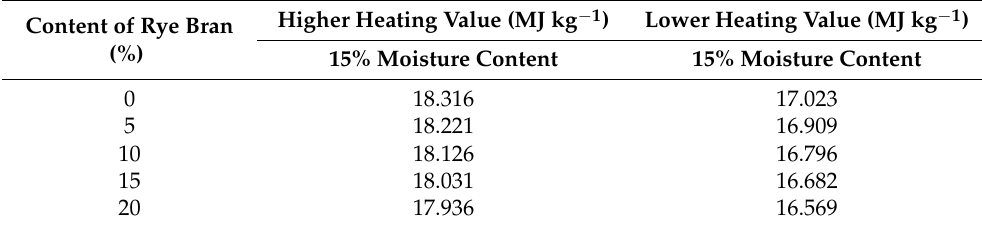
Table 3. Higher heating value and lower heating value of sage straw pellets with different rye bran